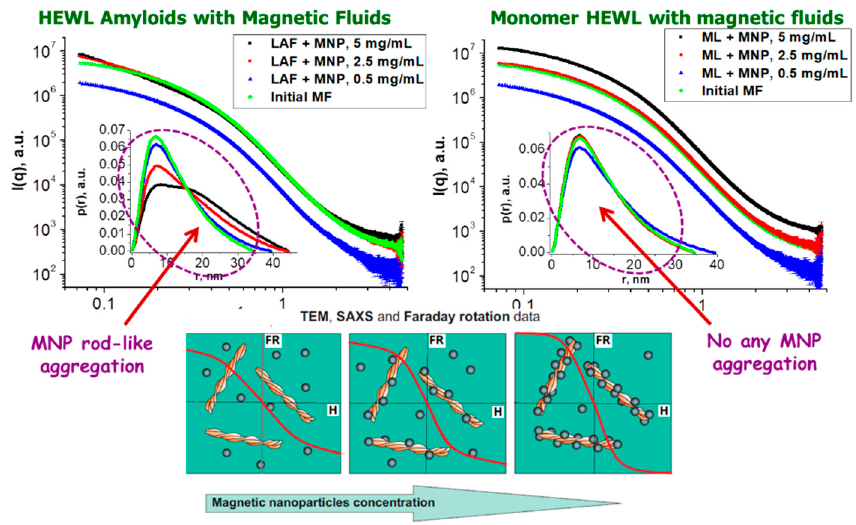
Figure 14. Behavior of magnetic nanoparticles in complex solutions of MNPs with amyloids (left) and with native (not aggregated) protein (right) according to small-angle X-ray scattering (SAXS) data. It’s also shown formation of some rod-like aggregates in solutions of MNPs with amyloids and there is no any change in MNPs solutions with native protein at various MNPs concentrations. Sketch of the found adsorption of MNPs on amyloids surface with increase of MNPs concentration according to TEM, SAXS and optical (Faraday rotation) results (bottom). Reprinted with permission from Reference [151].